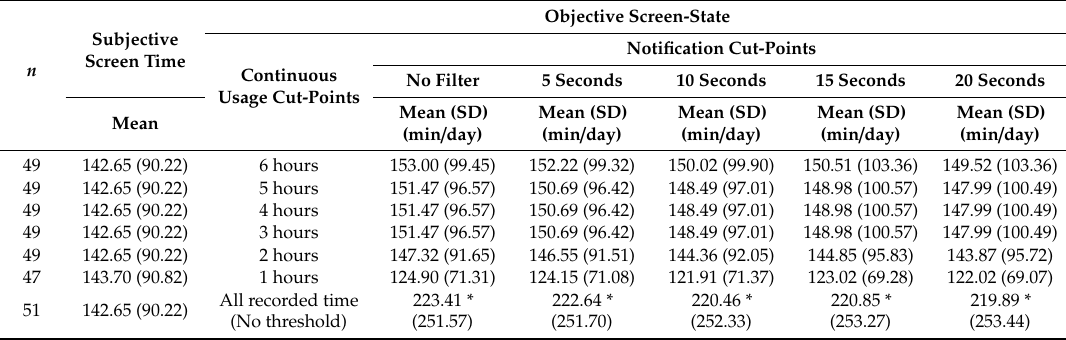
Table 4. Objective screen-state vs. subjective screen time on weekend days (minutes / day) ¥